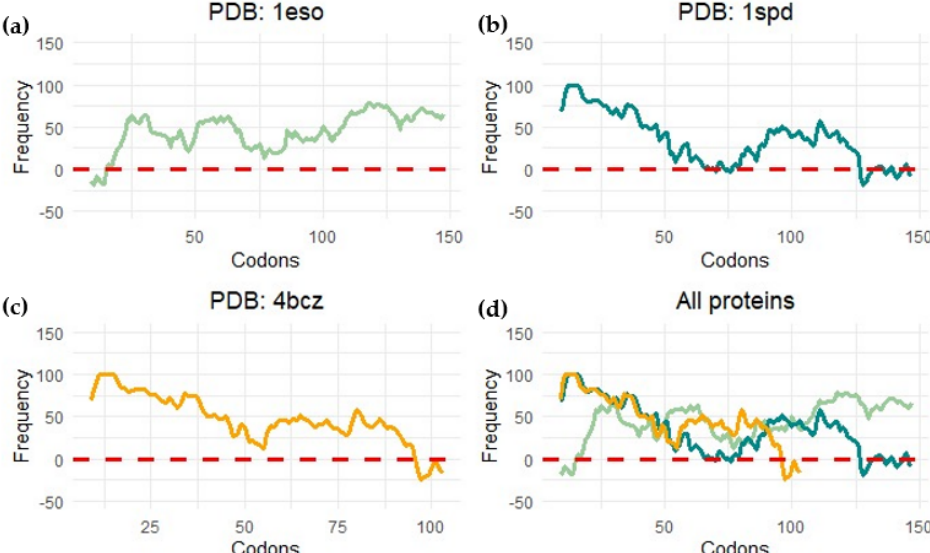
Figure 12. Rare codon cluster detection. This image shows the measure of codon frequency in three different proteins by using the %MinMax calculator (software published in [101]) for ( a ) Escherichia coli CuZn superoxide dismutase (PDB: 1eso); ( b ) human amyotrophic lateral sclerosis CuZn superoxide dismutase (PDB: 1spd); ( c ) monomeric human CuZn superoxide dismutase in which loops IV and VII are deleted (PDB: 4bcz); ( d ) all proteins.